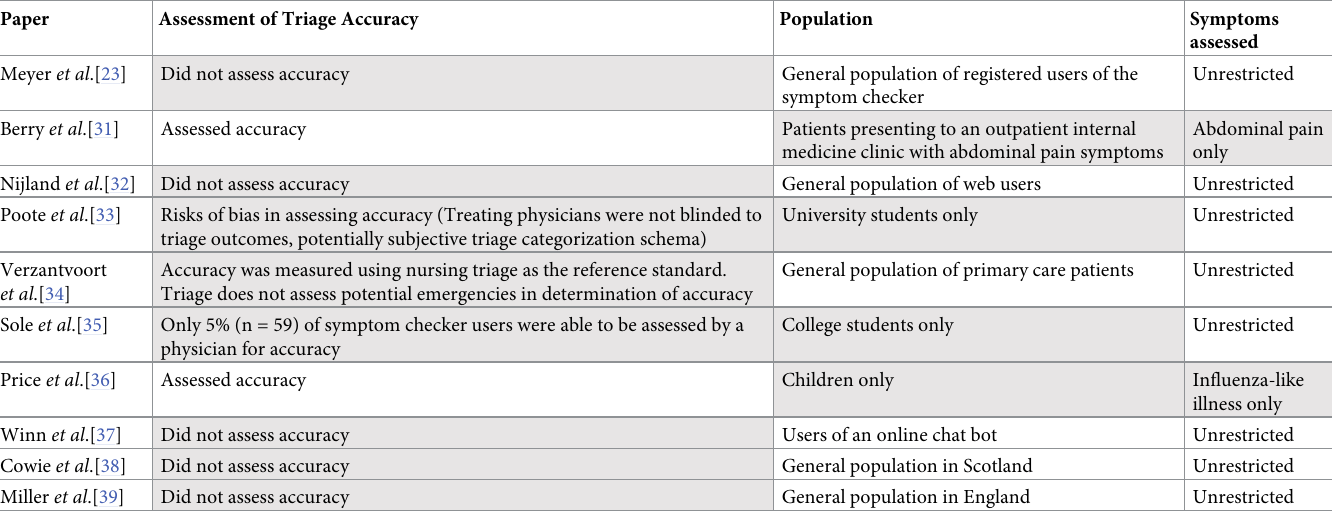
Table 4. Summary of peer-reviewed papers on symptom checker usage by patients. All studies were limited by at least one of three factors (in grey).